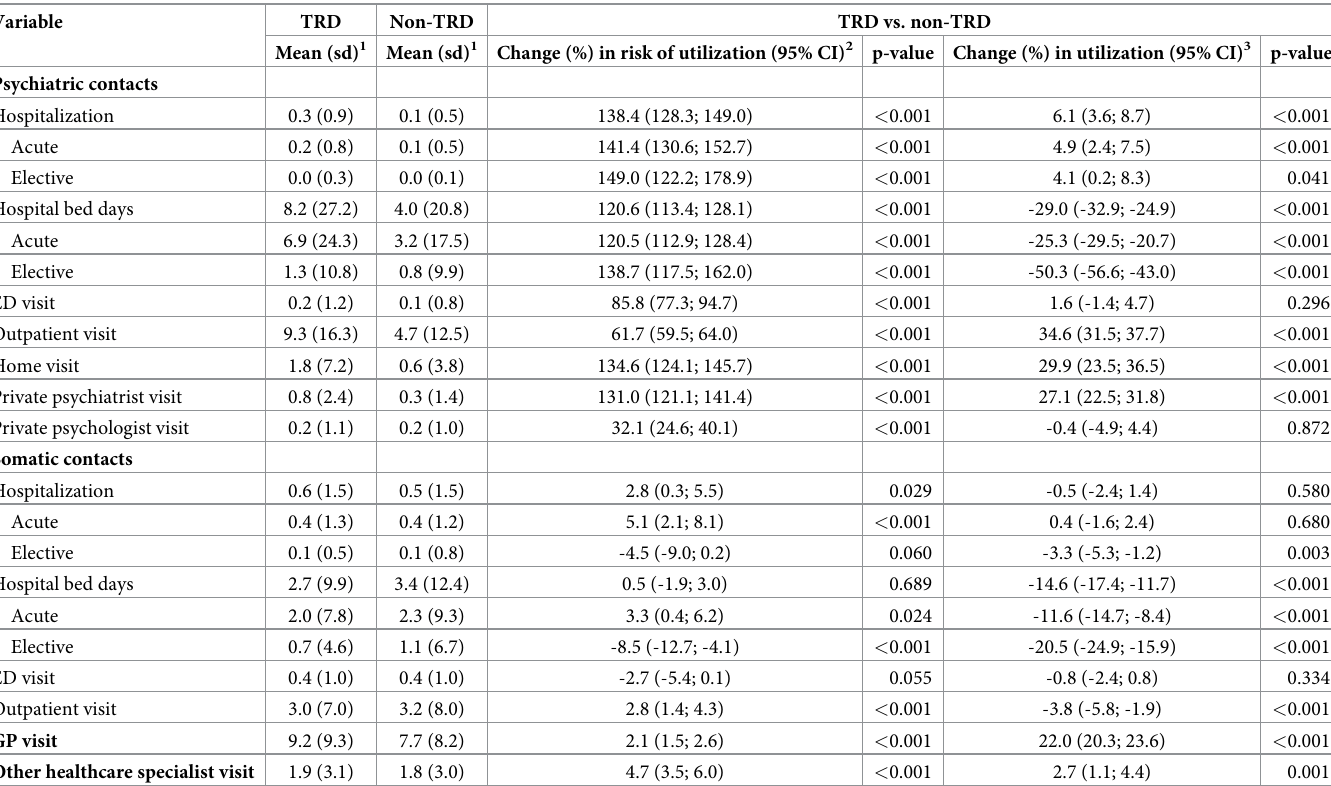
Table 2. Average healthcare resource utilization comparing TRD patients with non-TRD patients in the matched